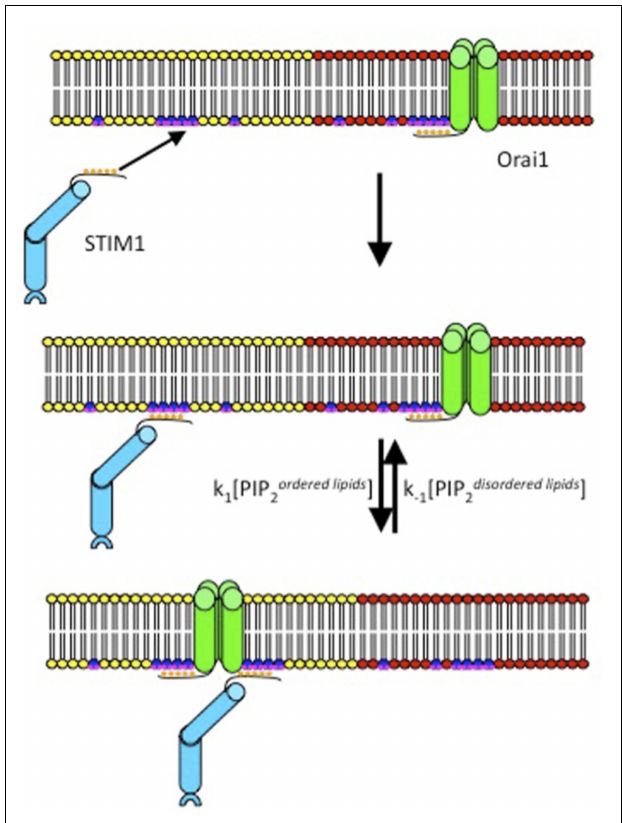
FIGURE 2 | Model for the sequence of events that initiate coupling of the ER sensor protein STIM1 to the CRAC channel protein Orai1. Activated STIM1 in the ER (not shown) binds initially via its C-terminal polylysine sequence to PIP 2 (blue/violet) in ordered lipids (yellow) at the inner leaflet of the plasma membrane. Concentration of STIM1 at this site facilitates its coupling to Orai1 that redistributes from disordered lipids (red) to ordered lipids. A basic polyarginine sequence in the N-terminus of Orai1 mediates its electrostatic interactions with PIPs and